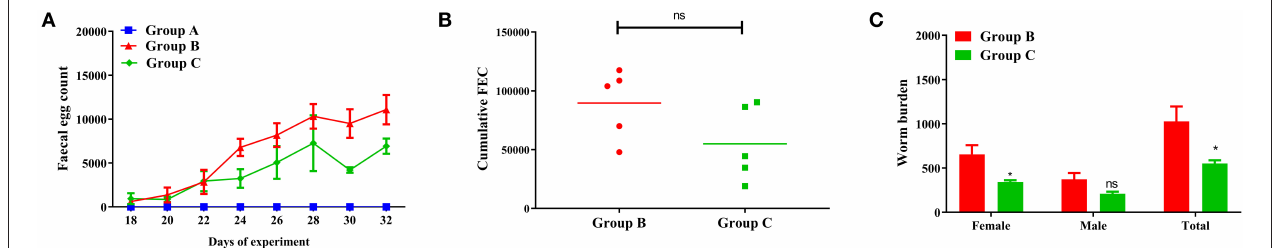
FIGURE 1 | Dynamics of egg outputs and statistics of abomasum worm burdens in trial 1. Group A, unchallenged goats; Group B, goats challenged with L3s at day 1; Group C, goats challenged with L3s at day 1 and then immunized by PcAb-rHc8 antibodies at days 2 and 3 post challenge. (A) FEC are presented as mean ± SEM. (B) Mean cFEC values presented the data of each goat in each group. (C) Worm burdens are presented as mean ± SEM (* p < 0.05, ns, non-significant vs. infection group), and a capped line designate significance between two groups (ns, non-significant).